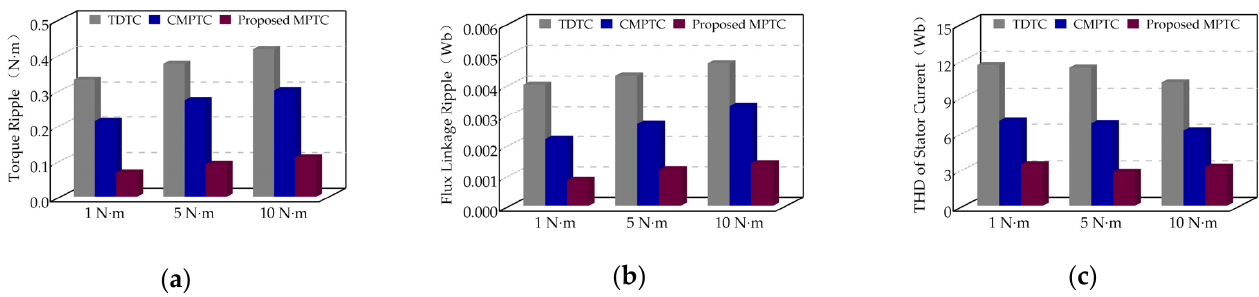
Figure 12. Comparisons of the steady-state performances of the three methods under different loads: ( a ) torque ripple, ( b ) flux linkage ripple, and ( c ) stator current total harmonic distortion (THD).